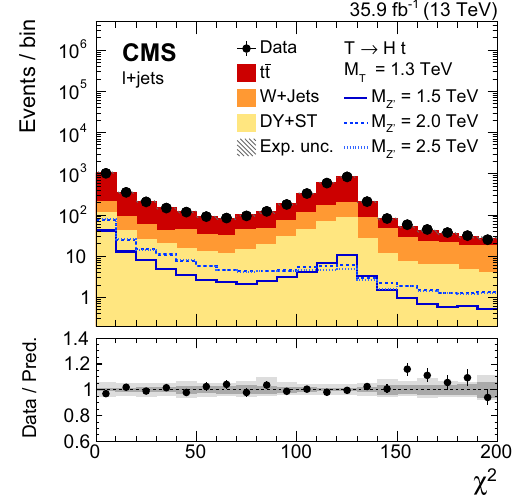
Fig. 3 Distribution of the smallest χ 2 discriminator in each event for the combination of both top tag and no top tag categories, after the tt reconstruction, combining both lepton channels. The simulated SM backgrounds are shown without corrections from the fit to data (explained in Sect. 6). The expected signal distribution is shown for var- ious M Z (cid:3) masses for a fixed mass M T = 1 . 3TeV in the T → Ht decay channel, each with a nominal cross section σ( Z (cid:3) → tT ) of 1pb. The lower panel shows the ratio of data to predicted background. Here the darker grey band indicates the statistical uncertainty, whilst the lighter grey band shows the combined statistical and systematic